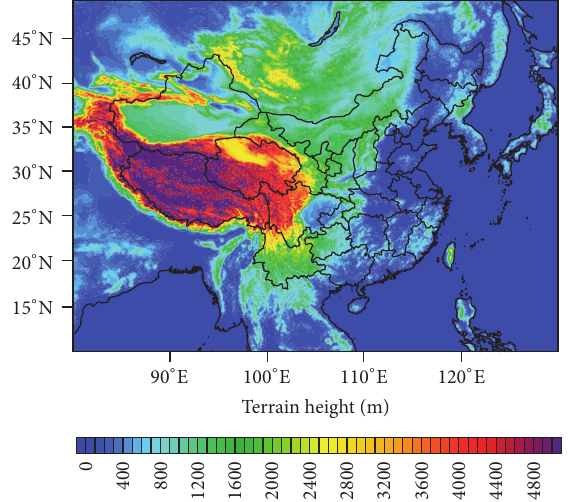
Figure 1: WRF model domain and topography height map and the color scale refers to